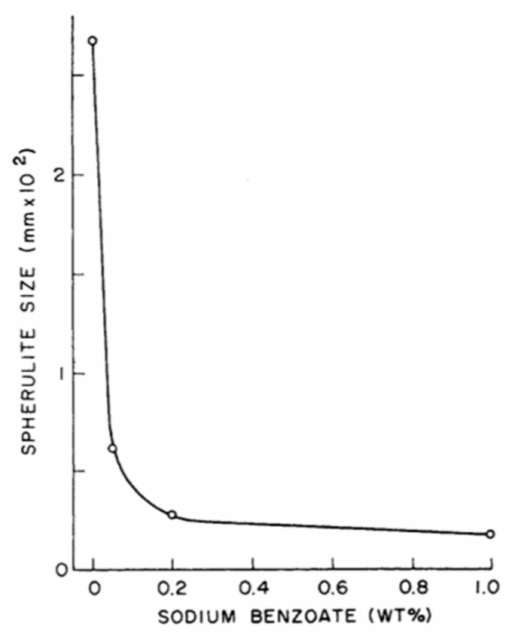
Figure 8. Spherulite diameter refinement of iPP through the addition of nucleating agent, sodium benzoate [117]. Reproduced with permission from Ref. [117]. Copyright (1984), Polymer Engineering and